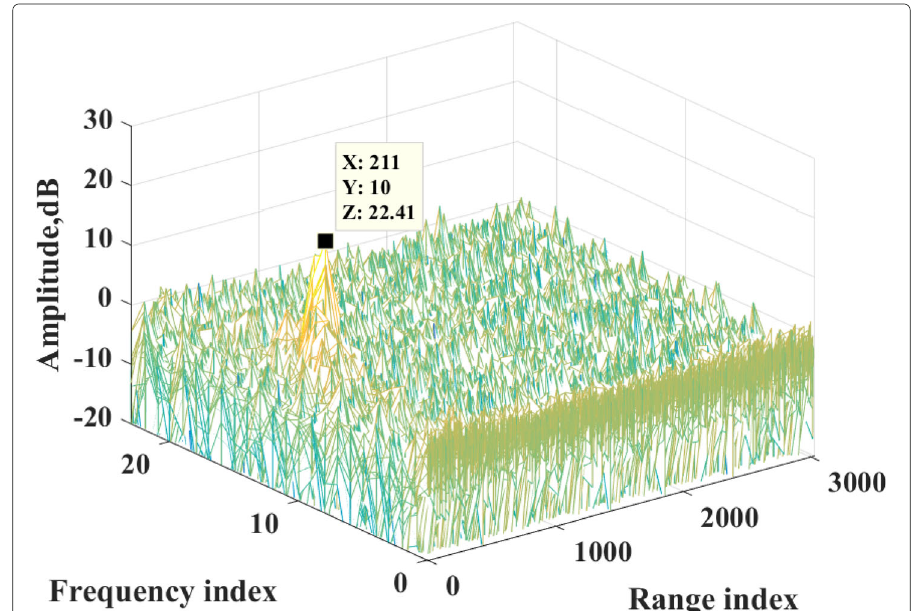
Fig. 11 Coherent integration output of signal processed by the proposed